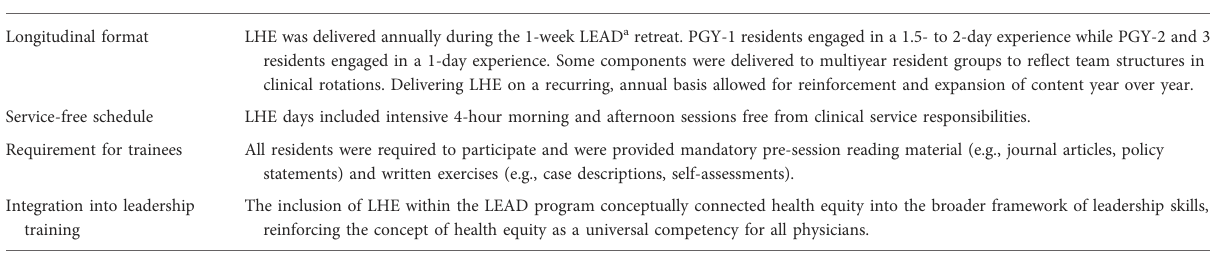
TABLE 1A Leaders in Health Equity (LHE) design principles and detailed approaches.